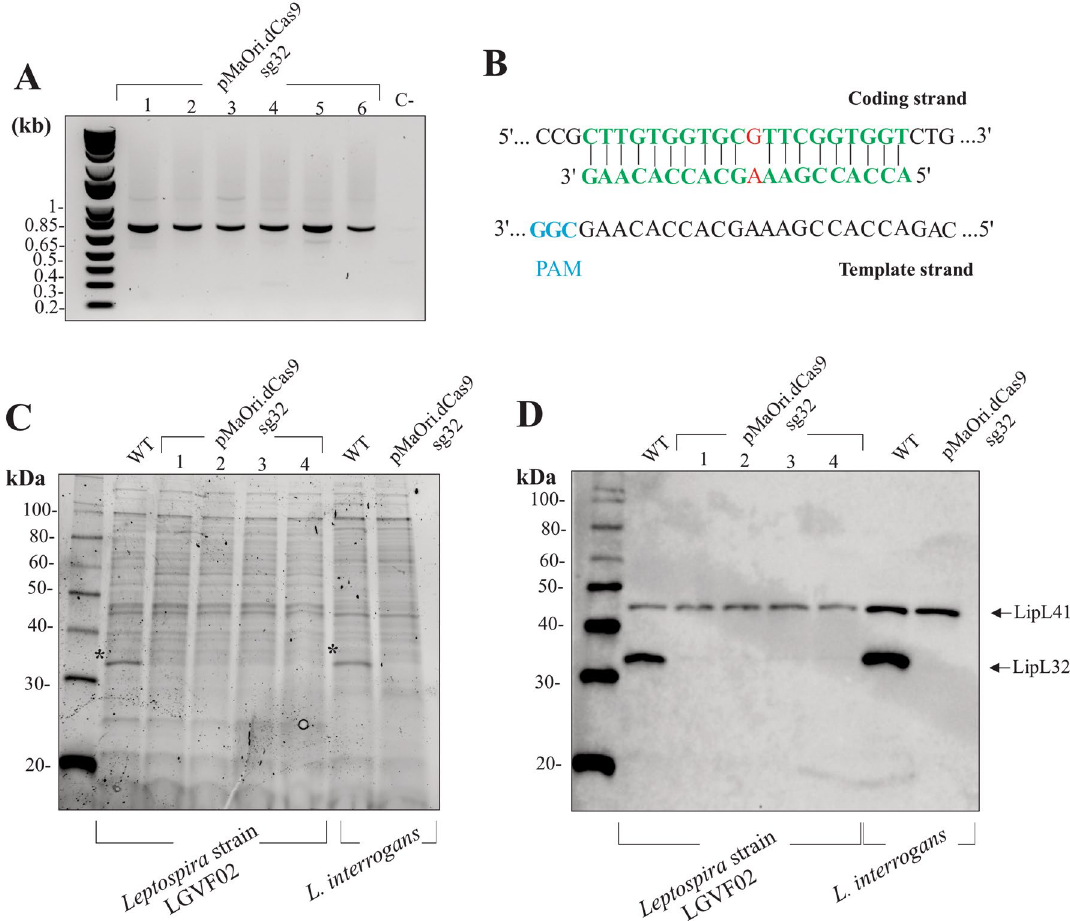
and recovered colonies were evaluated by PCR with pMaOri2 primers ( A ). Based on the lipL32 gene sequence, a mismatch is expected ( B ). Whole cell extracts from wild type (WT) and 4 transconjugants containing the plasmid were evaluated by SDS-PAGE ( C ) and immunoblotting ( D ) with anti-LipL32 and anti-LipL41 antibodies. Wild type or plasmid-containing L. interrogans were included as